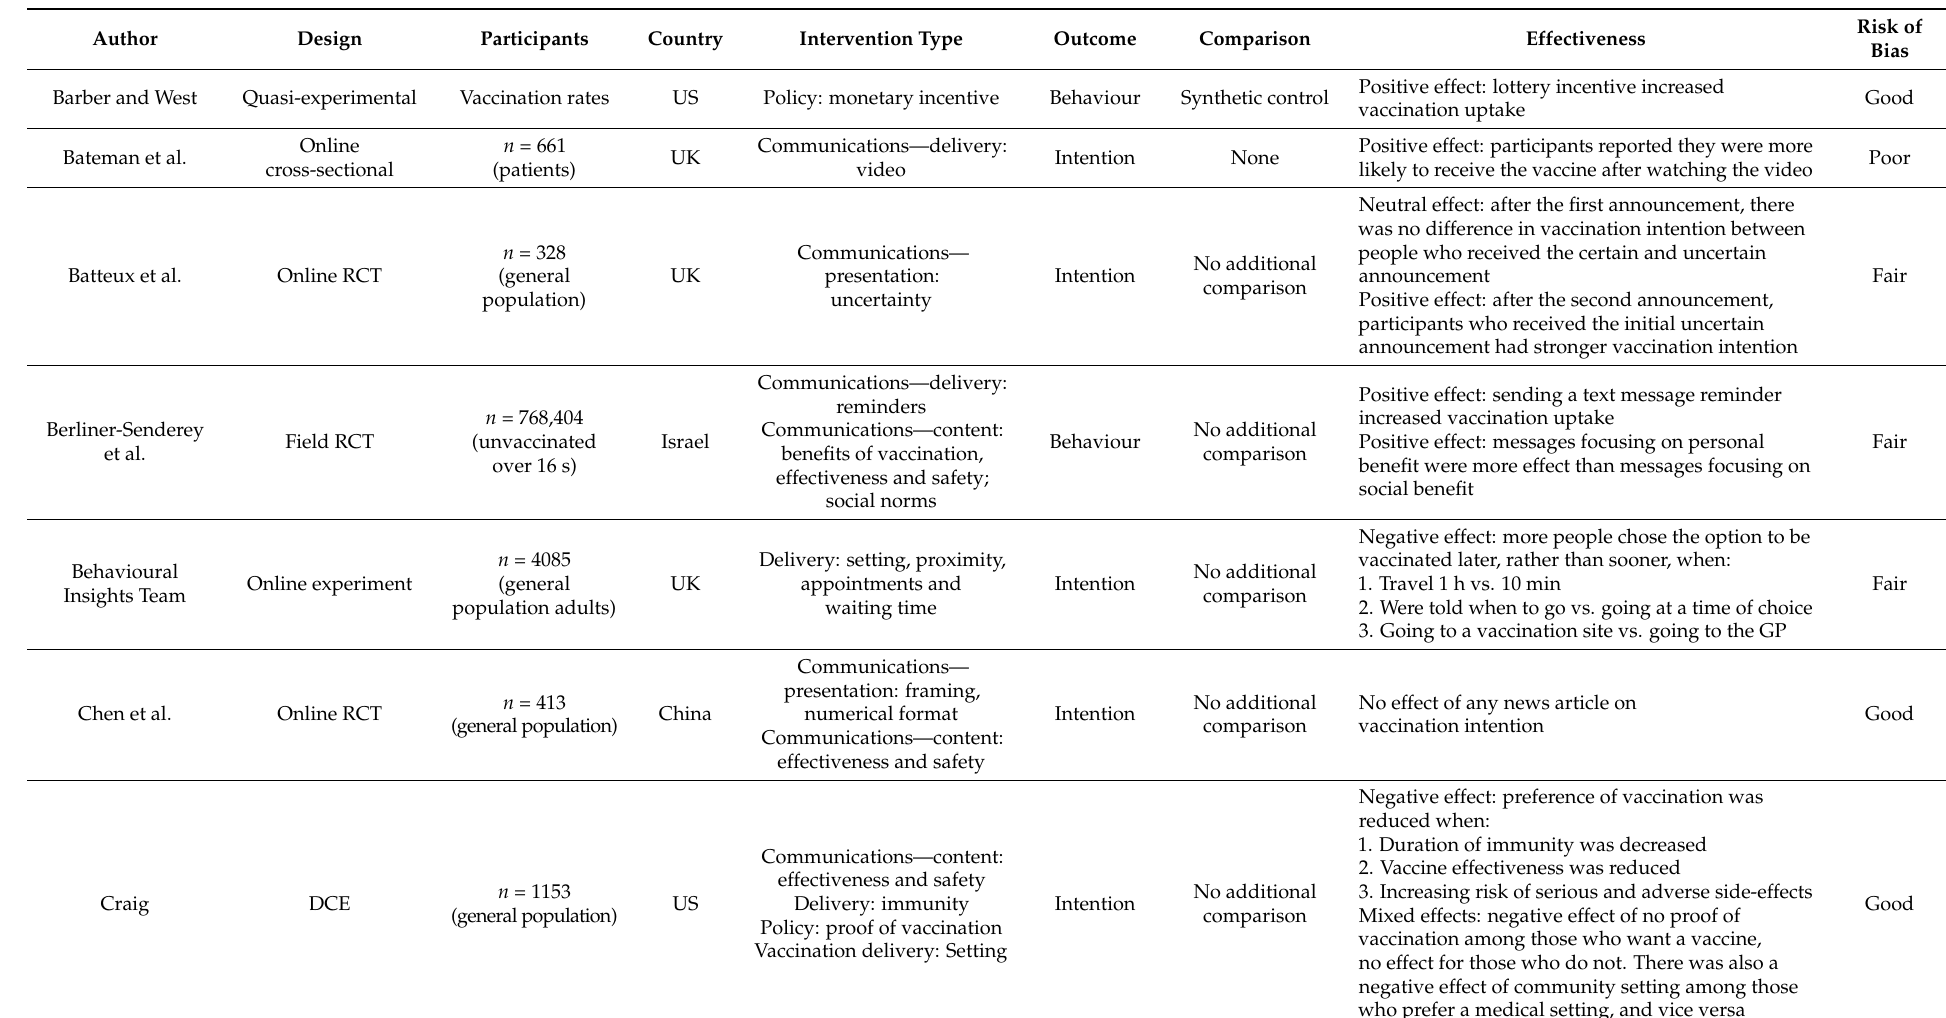
Table 1. Characteristics of included